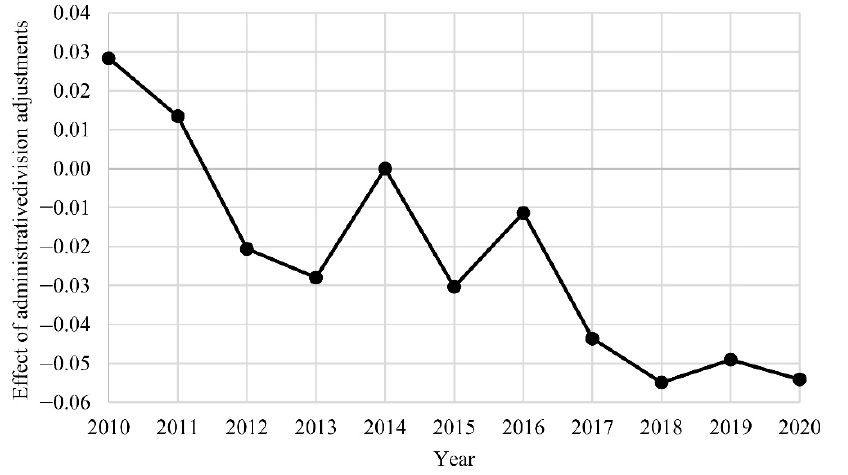
Figure 4. Changing trend in the annual influence coefficients of the administrative division adjustment.